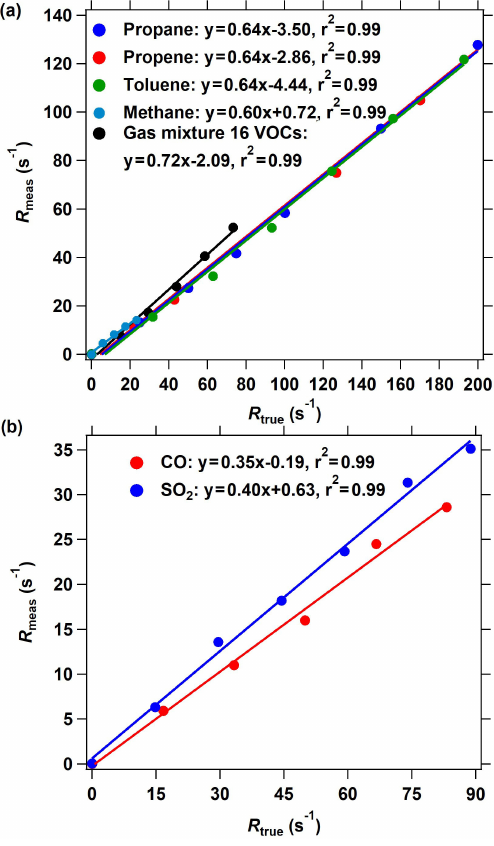
Figure 4. The OH reactivity calibration of the improved CRM sys- tem using different standard gases. (a) The calibrating results of organic species including methane, propane, propene, toluene, and a mixture of 16 VOC species through arm C. (b) The calibrating results of inorganic species including CO and SO 2 . The measured OH reactivity was calculated based on the C2 mode shown in Fig. 2 in the ICRM